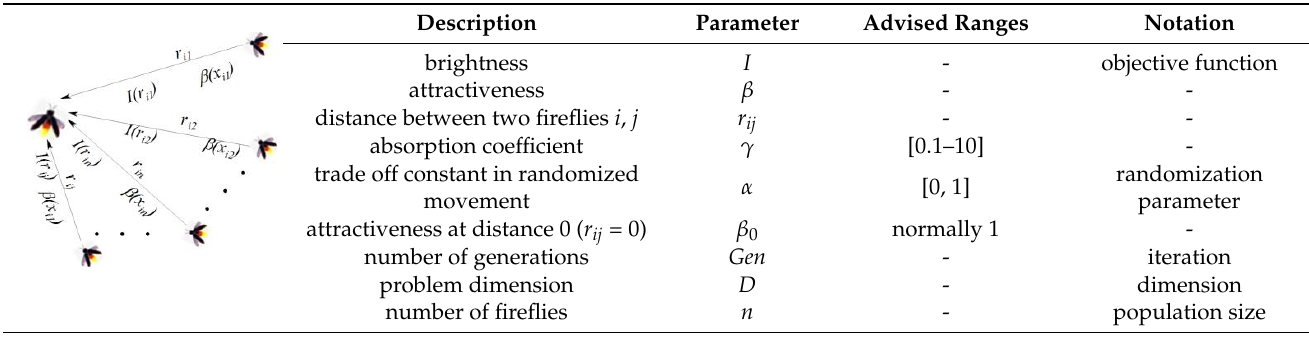
Table 1. Required parameters to tune the FA .